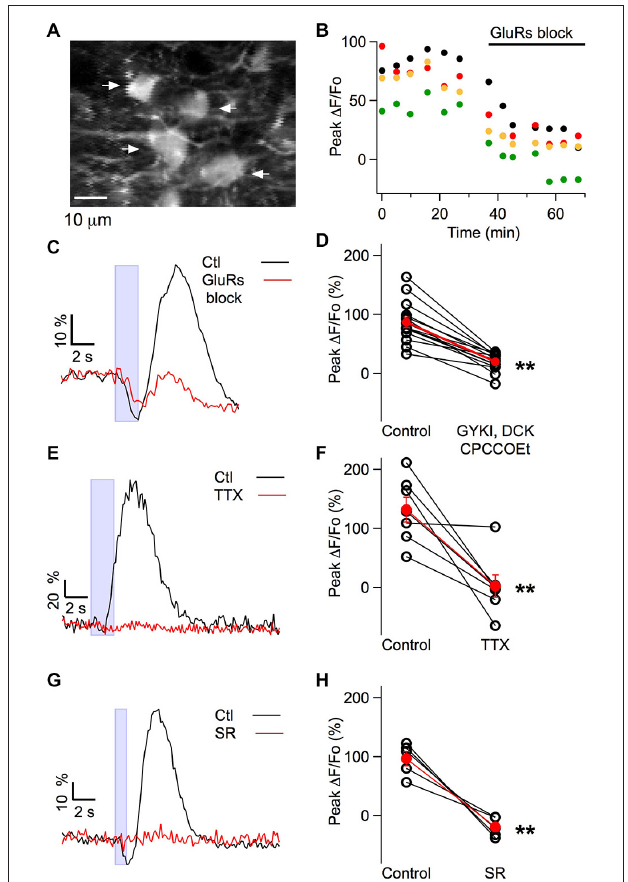
FIGURE 4 | Pharmacological profile of the muscimol-evoked Ca i rises obtained in MLIs in vivo . (A) Average of 30 pre-stimulus two-photon laser scanning images of MLIs. (B) A cocktail of glutamate receptor blockers (GYKI 100 µ M, APV 20 µ M, CPCCOEt 100 µ M) decreased the peak somatic ∆ F/Fo induced by muscimol in the four MLIs somata indicated by arrows in (A) . (C,E,G) Representative examples for the time course of the somatic fluorescence changes induced by muscimol iontophoresis in control conditions and after addition of the indicated blockers to the solution bathing the craniotomy. Blue boxes denote the time of muscimol application. Concentrations for the glutamate receptor blockers in (C,D) were as in (B) ; in (E,F) TTX was used at 4 µ M; in (G,H) SR95531 was used at 75 µ M. Note that in (C) , the fluorescence increase (reflecting excitation) was highly sensitive to the glutamate receptor antagonists whereas the decrease in fluorescence (reflecting inhibition) was unaffected. (D,F,H) Pair plots for the peak somatic ∆ F/Fo values in control conditions and in the presence of the indicated drugs. Open symbols represent individual somata and red dots the corresponding average; error bars are SEM. The average block by the glutamate antagonists was 78 ± 5%, n = 15 somata from six mice ( p = 3 × 10 − 7 ). TTX completely blocked the response with an average block of 98 ± 17%, n = 7 somata from six mice ( p = 0.005). SR95531 completely blocked the response with an average block of 117 ± 6%, n = 5 somata from four mice ( p = 0.004). All p values are for paired Student’s t -test. ** p < 0.01. F 910 /F 810 values (see “Materials and Methods” Section) were monitored in two of the glutamate blocker experiments in control and in the presence of the blockers and no significant difference was found ( p value for paired Student’s t -test: 0.50) arguing against significant changes in basal Ca i levels. SR95531. This drug eliminated the muscimol-induced excitation (mean reduction: 117 ± 6%; five MLI in four animals; p = 0.004), ruling out the possibility of direct stimulation ( Figures 4G,H